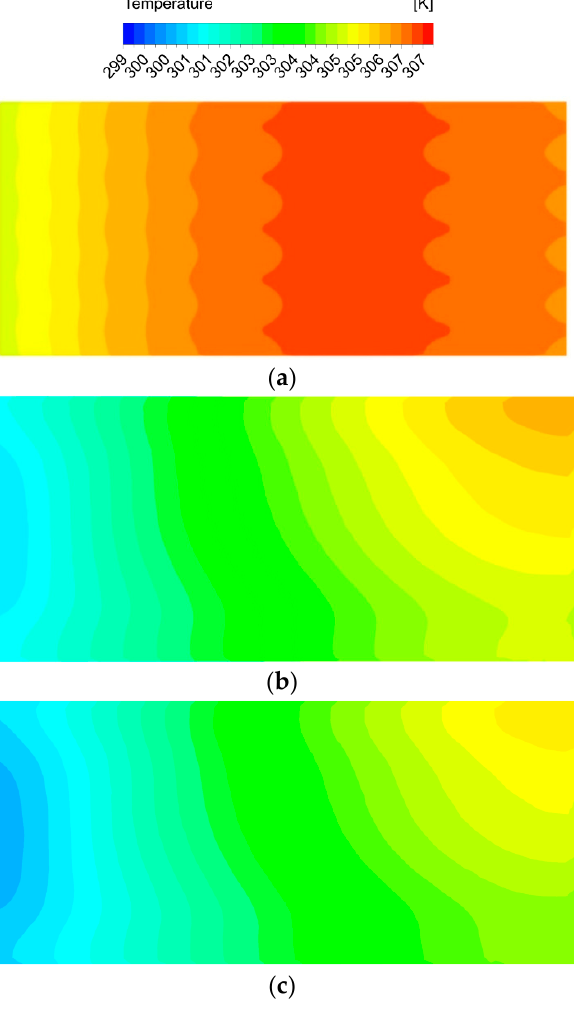
Figure 15. Velocity vectors on the mid-span sections of ( a ) top layer subchannel and ( b ) bottom layer subchannel in the DL-IM channel when Re = 132. 3.4. Overall Performance Evaluation The intensity of the secondary flow ( Se ) for DL-T, DL-M and DL-IM is compared in Figure 16. It shows that S e increases with Re in all three cases. Moreover, the secondary flow intensity of DL-M and DL-IM is much higher than that of DL-T, and the flow intensity of DL-IM is slightly higher than that of DL-M unless Re < 130. It implies that the configuration of the matrix and slot subchannel induces more intense flow at the cross section of DL-M and DL-IM. The coolant flows along the subchannel and changes the flow direction with twice the rib angle. Thus, the vortices are easily formed in the intersection area and slot subchannel where the strong coolant mixing is produced.